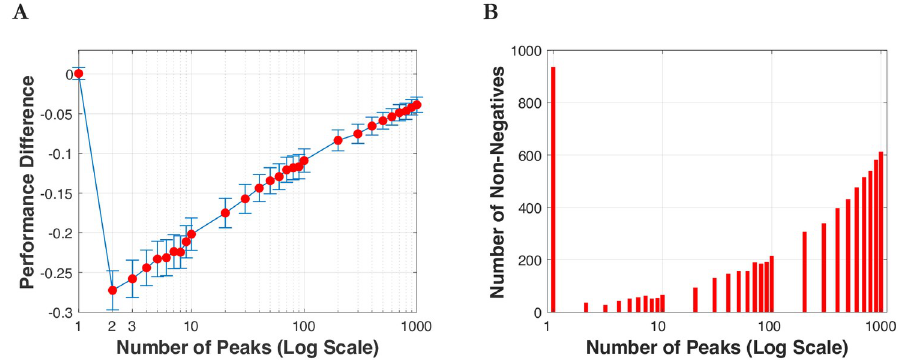
Fig 8. Number of peaks and learning consequences. (A) Performance difference after learning; negative values indicate a performance decline (B) Number of times the learning individual experiences non-negative performance changes out of 1,000 learning